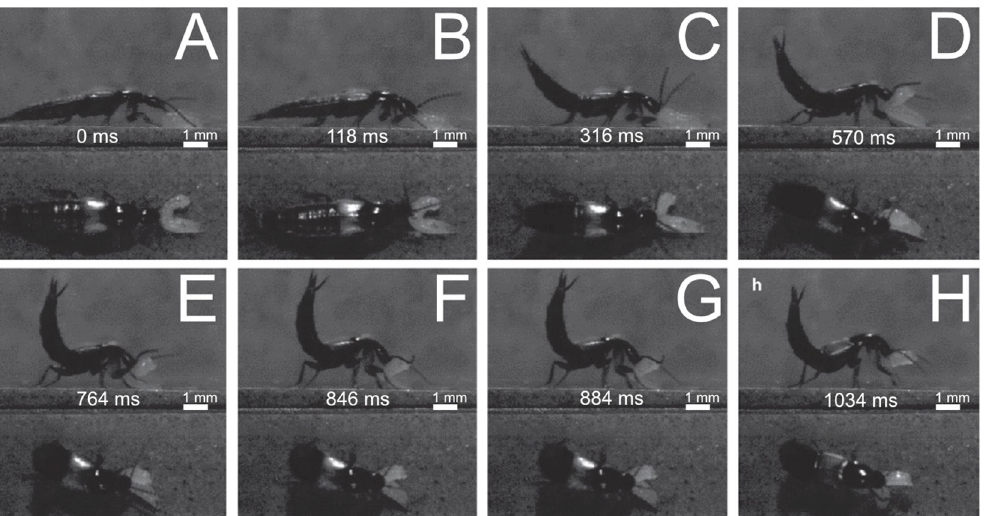
Figure 20. Philonthus varians . Pulling, i.e., direct seizure with the mandibles followed by lifting and dragging the prey backwards (lateral and dorsal aspects). Time course of depicted sequence is provided in milliseconds elapsed from the start (= image A ). Images B – H depicting the process of prey capture. For further description, see text. Source: [47].